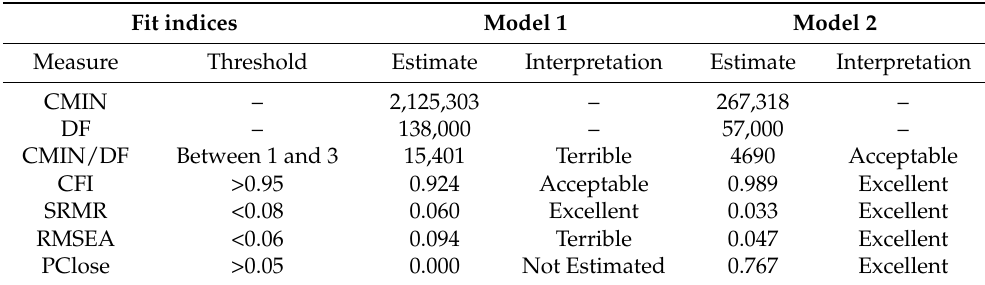
Table 3. Indices of statistical goodness of fit of the measurement model (n =